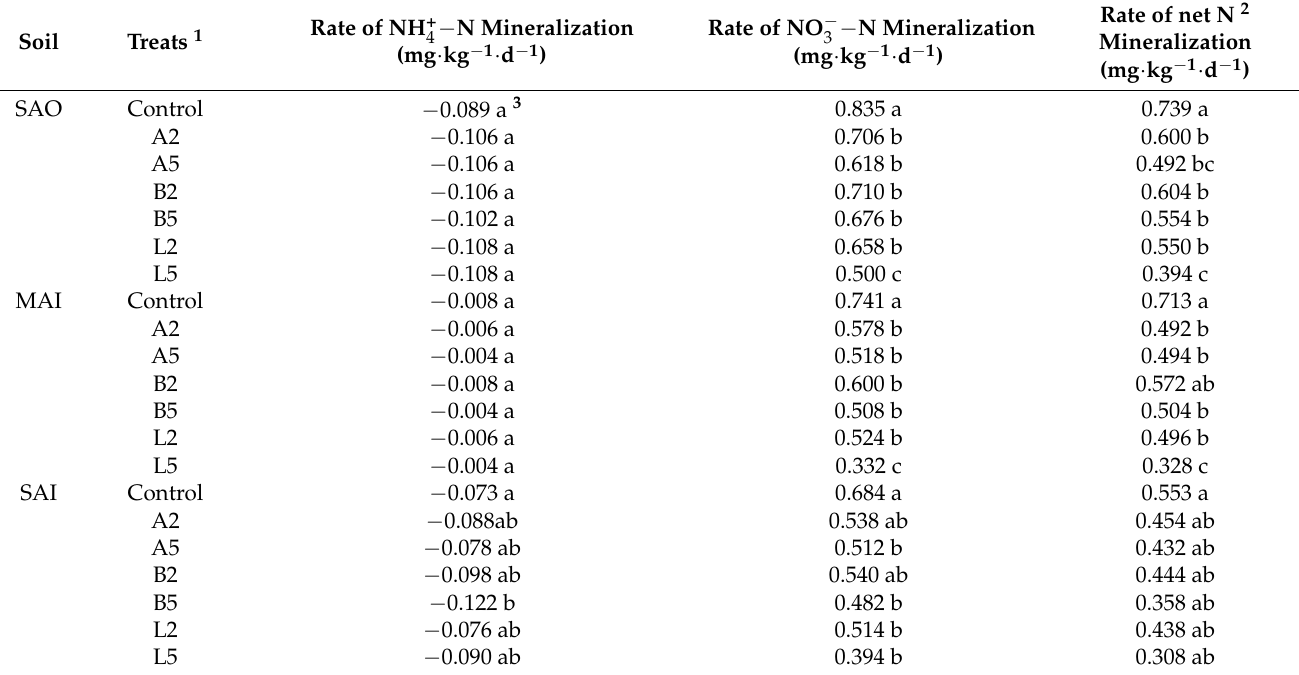
− N mineralization and net N mineralization at the end of the incubation